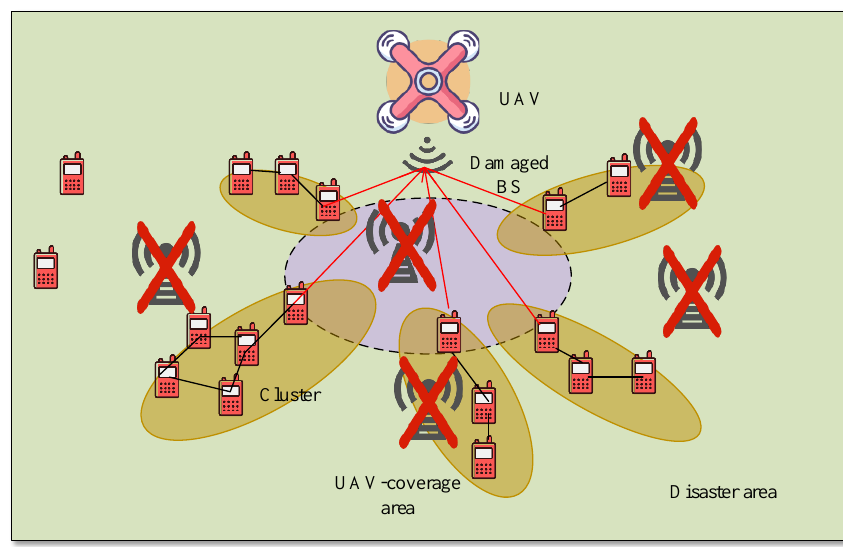
Figure 10. Architecture of the UAV and D2D communication